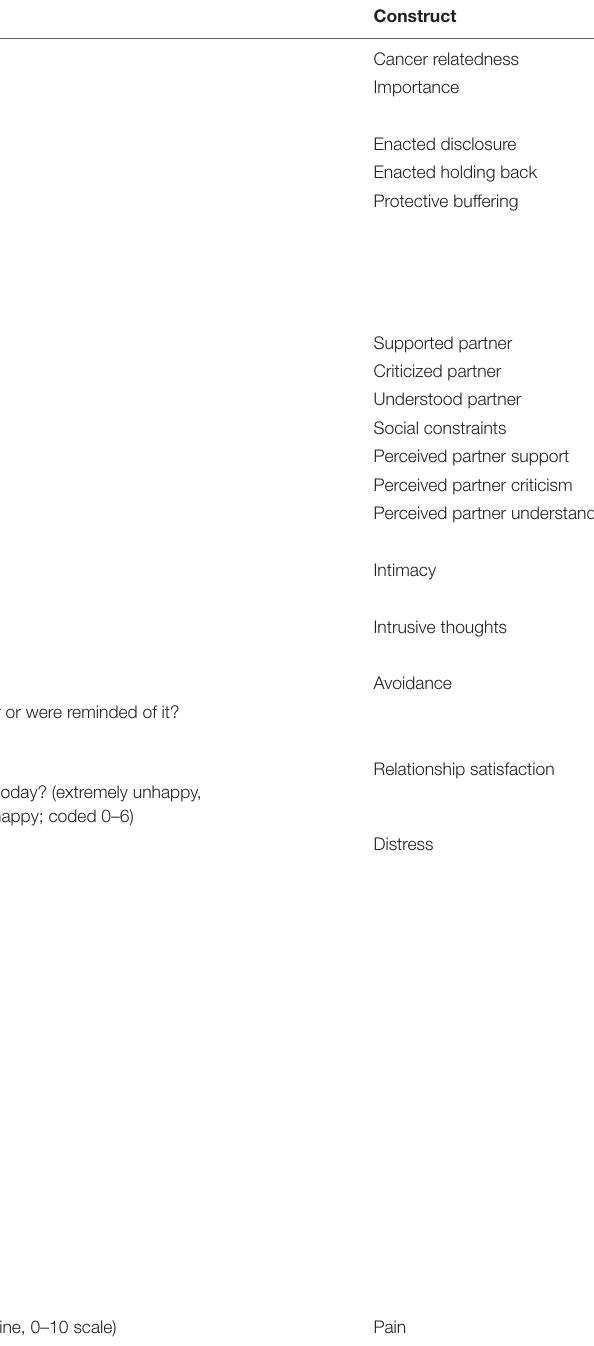
TABLE 2 | Smartphone-delivered ecological momentary assessment (EMA)